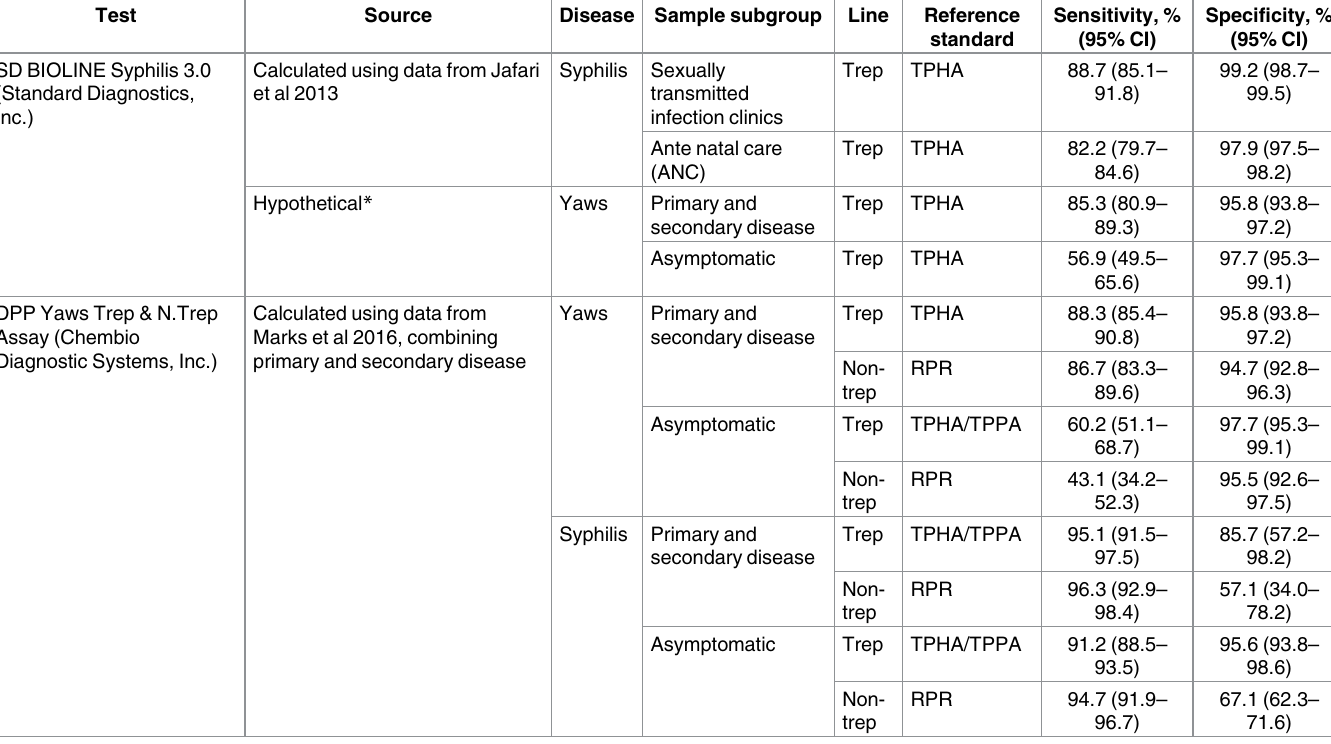
Table 1. Reported sensitivities and sensitivities for DPP Yaws Trep & N.Trep assayand SD BIOLINE syphilis